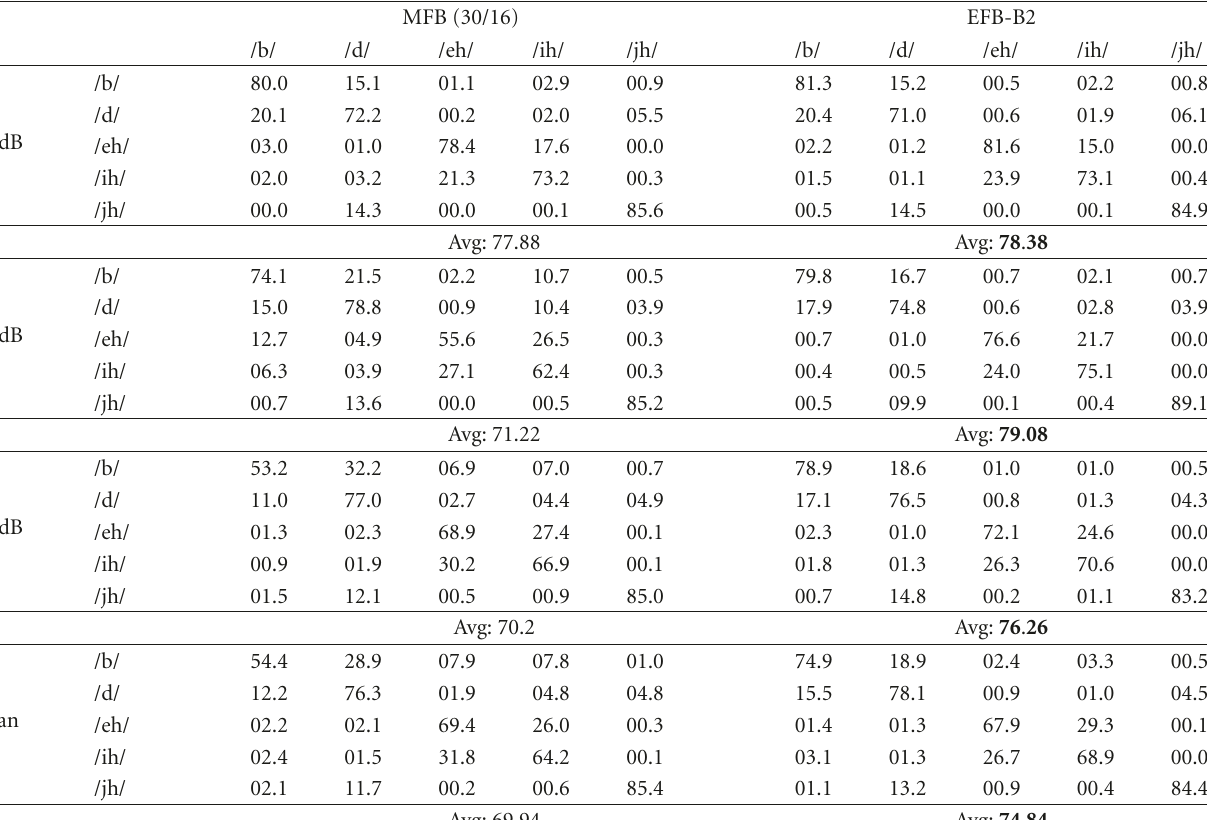
Table 4: Confusion matrices showing percents of average classification rates from ten data partitions in MT conditions, for both MFB and EFB-B2.